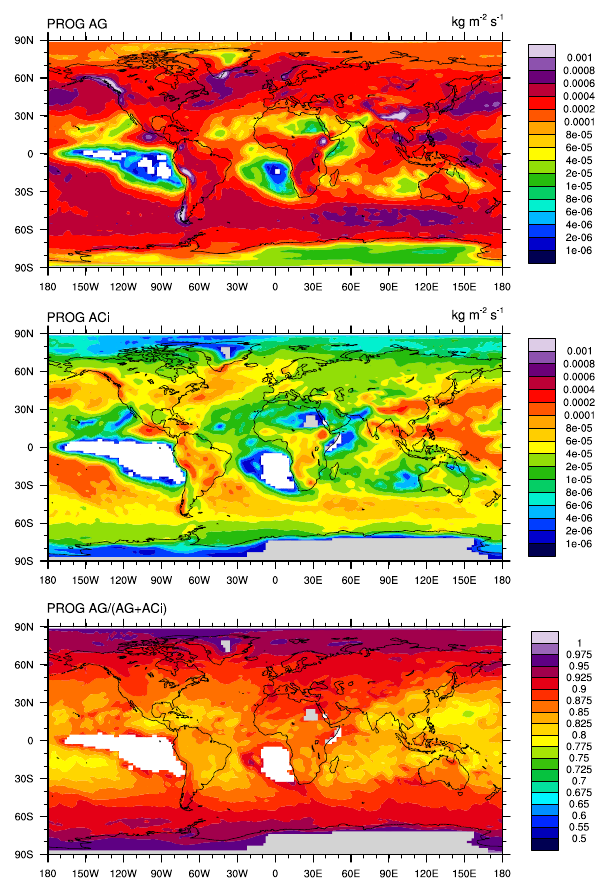
Figure 11. Mean vertically integrated aggregation (AG) and (ice) accretion rates (ACi) of PROG for the year 2000, such as the frac- tion of AG to the total collection rate (AG +